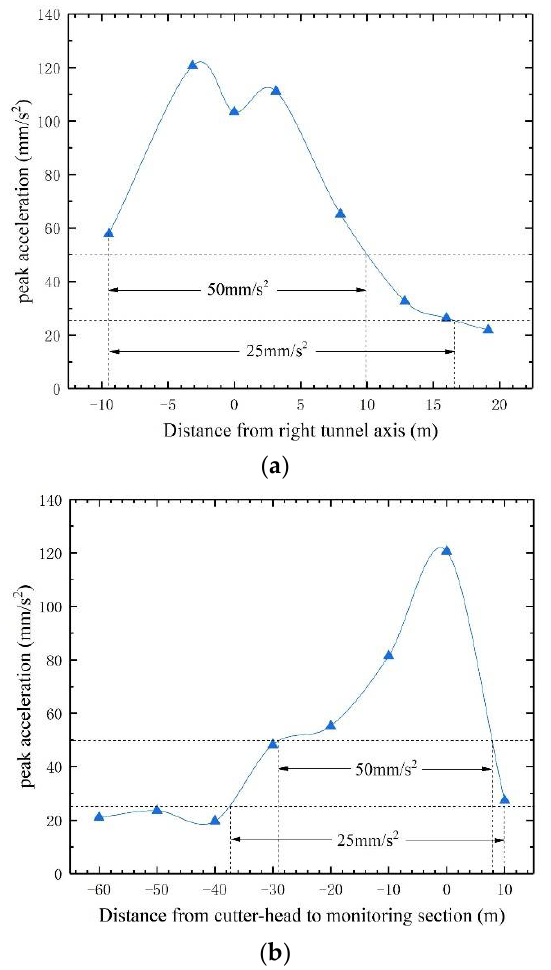
Figure 11. Vibration influence range of double-shield TBM construction. ( a ) Transverse influence range; ( b ) Longitudinal influence range. Table 5. The vibration influence range of double-shield TBM construction.